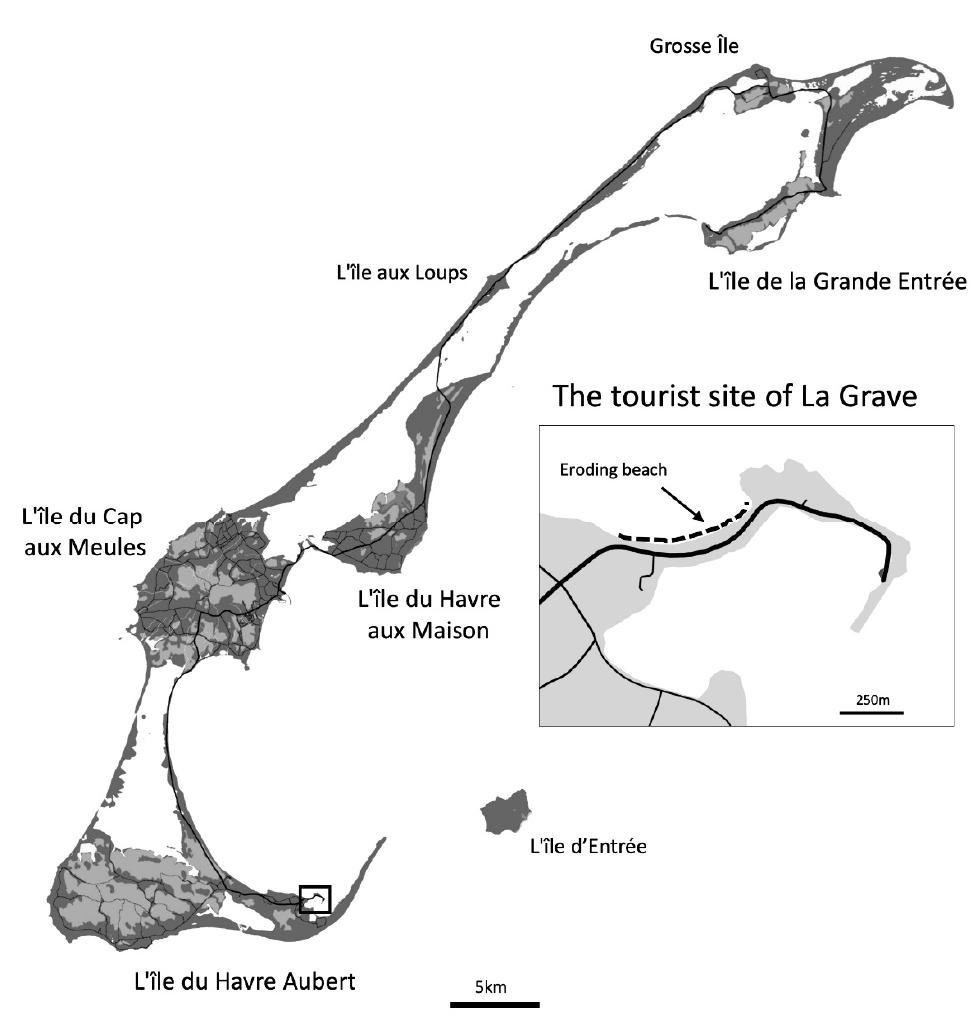
Figure 2. Localization of the Tourist site of La Figure 2 : Localization of the Tourist site of La Grave.